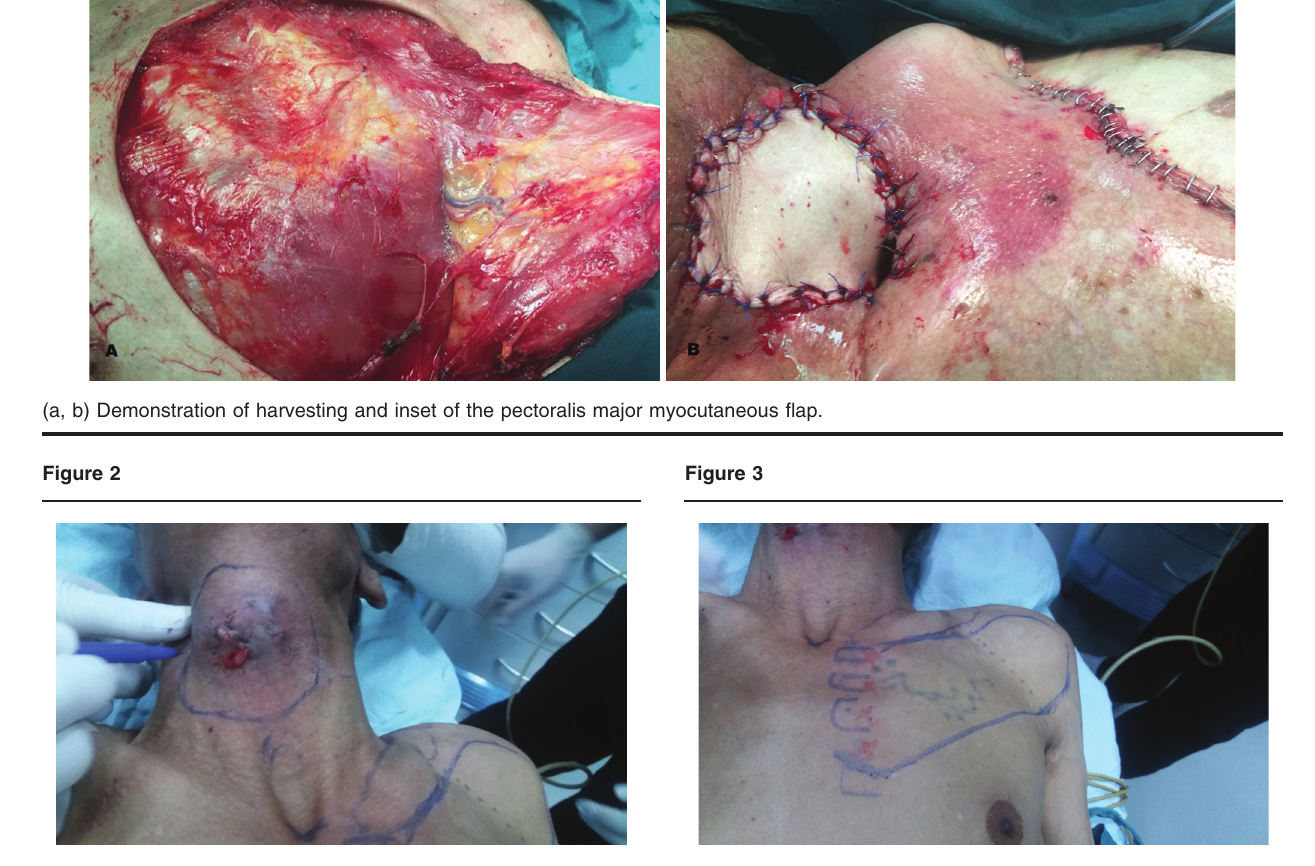
Preoperative appearance of cancer larynx with frank skin invasion. Marking of the deltopectoral